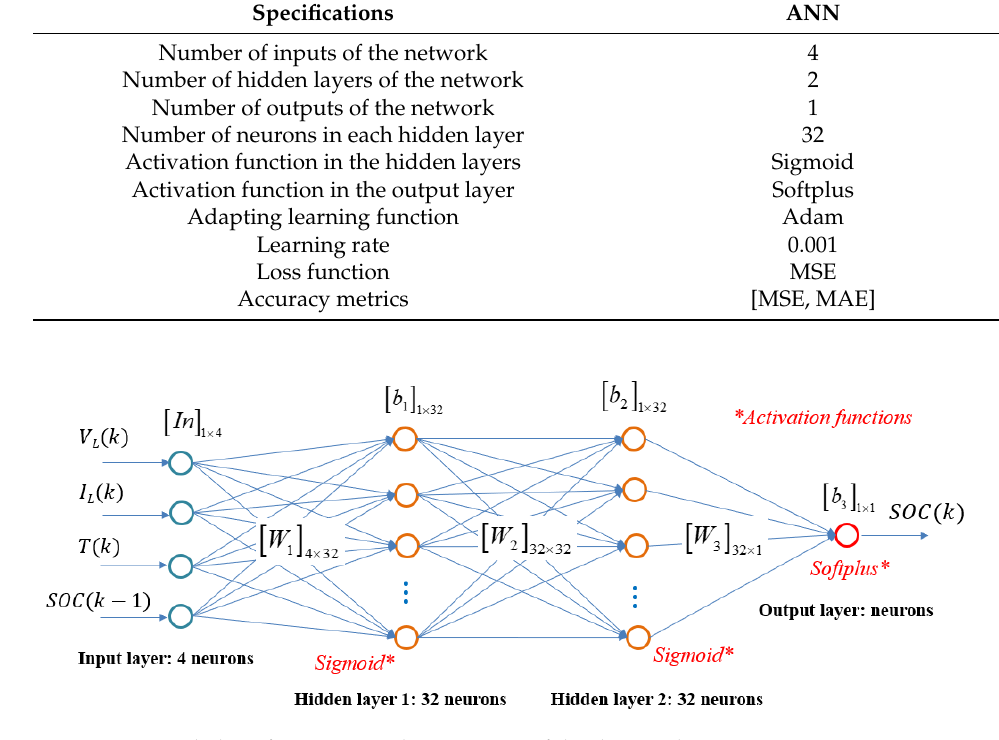
Table 5. Final specifications of the ANN combined with the EKF.